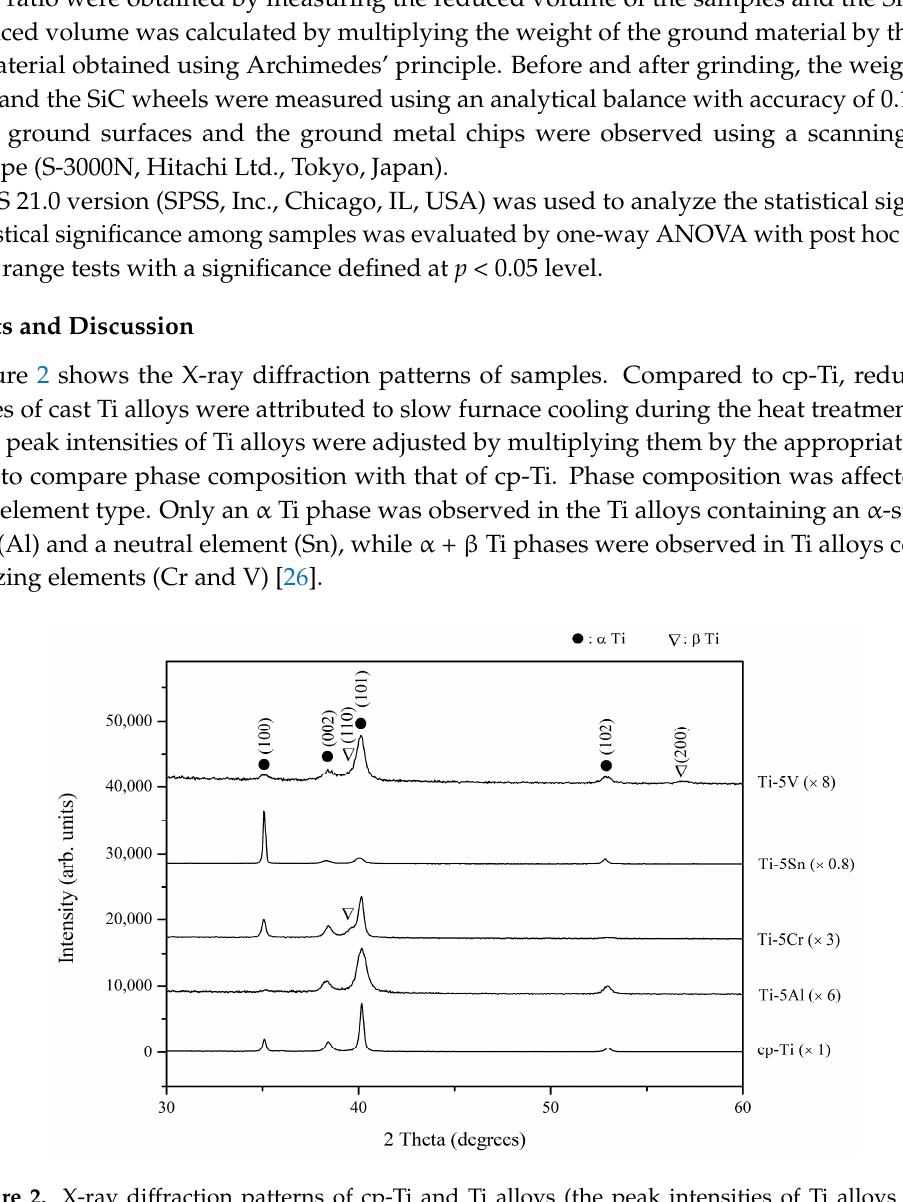
Figure 2. X-ray diffraction patterns of cp-Ti and Ti alloys (the peak intensities of Ti alloys were multiplied by the number in parentheses).